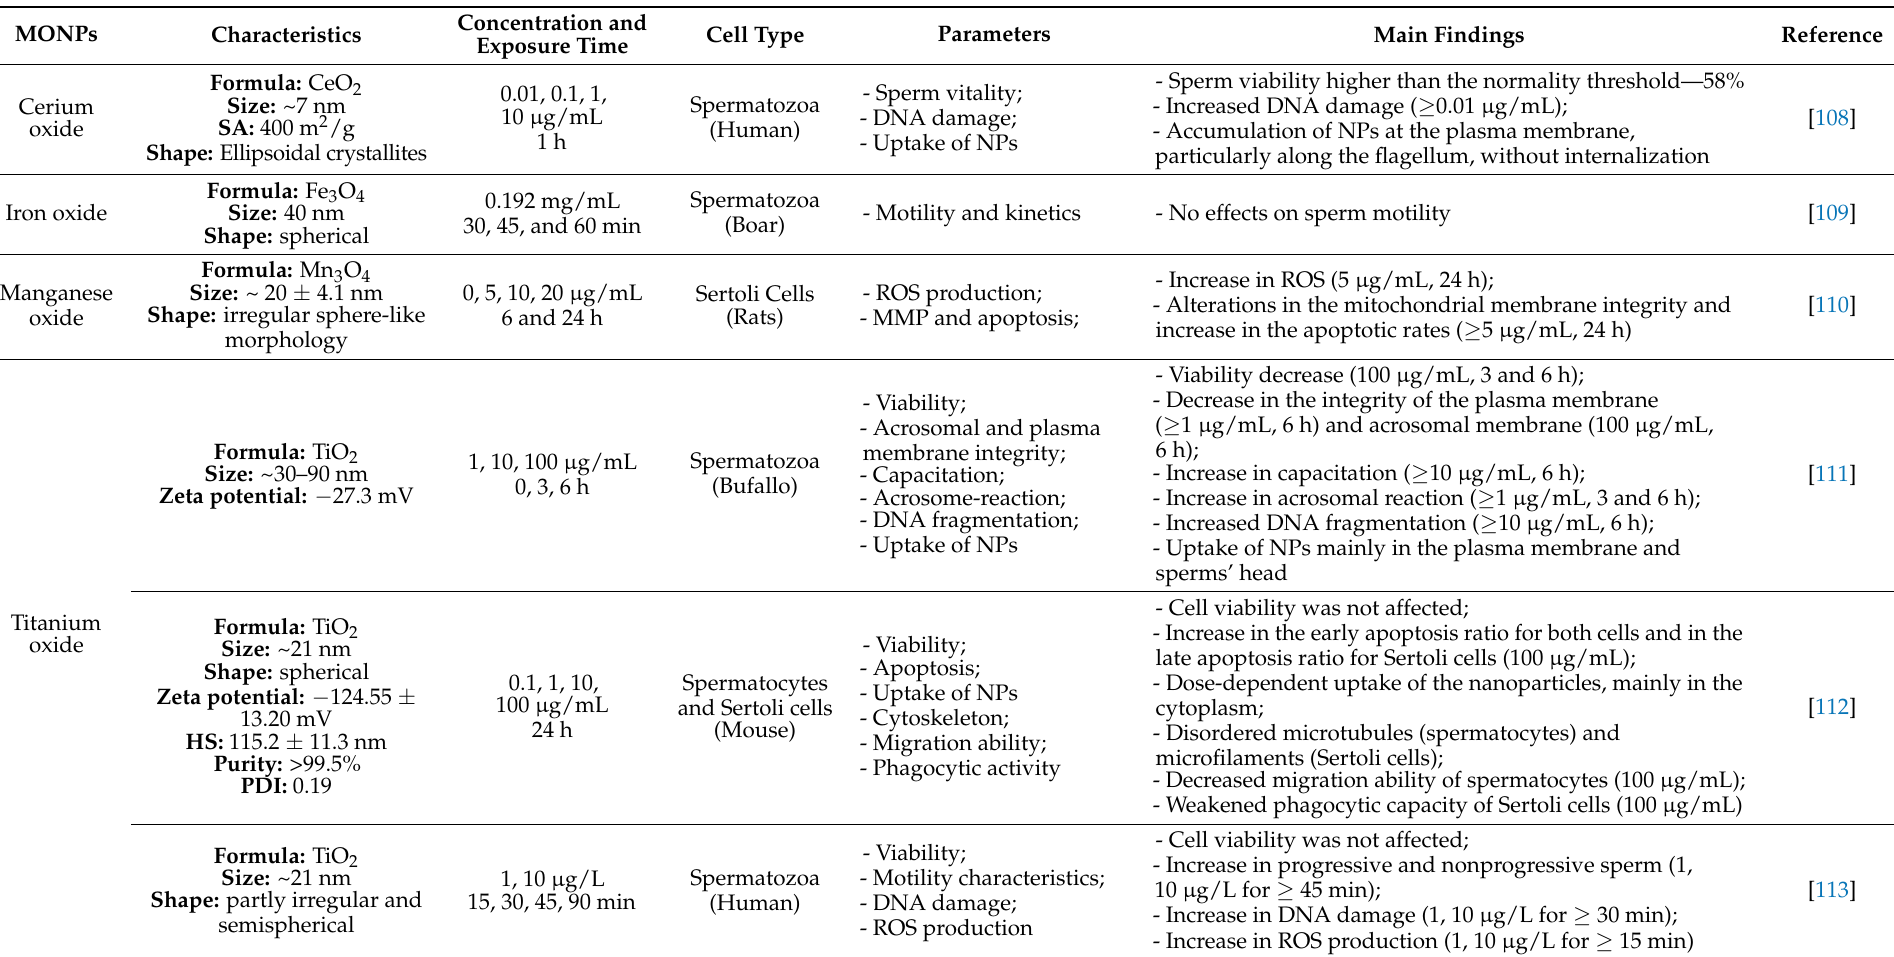
Table 1. In vitro studies of adverse effects of MONPs on mammalian male germ cells. The conditions where the main findings were observed are indicated in brackets.